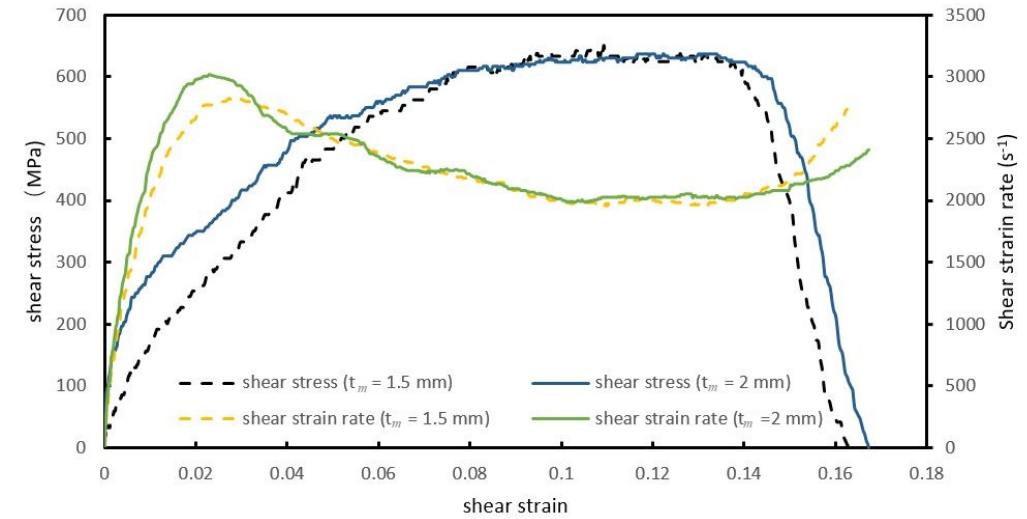
Figure 8. Shear stress–strain curves of the two geometries under the same strain rate. Three tests were conducted under the same shear strain rate (the same geometry and same impact velocity) to check the repeatability of the experiment. To achieve the same strain rate, the impact indicate that the shear stress–strain curves are